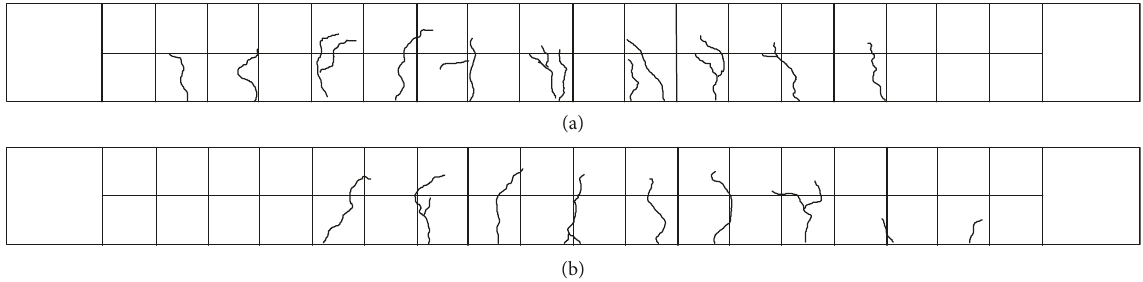
Figure 8: Crack patterns observed in RC beam specimens after the fatigue test: (a) RC-SR; (b) RC-HR.